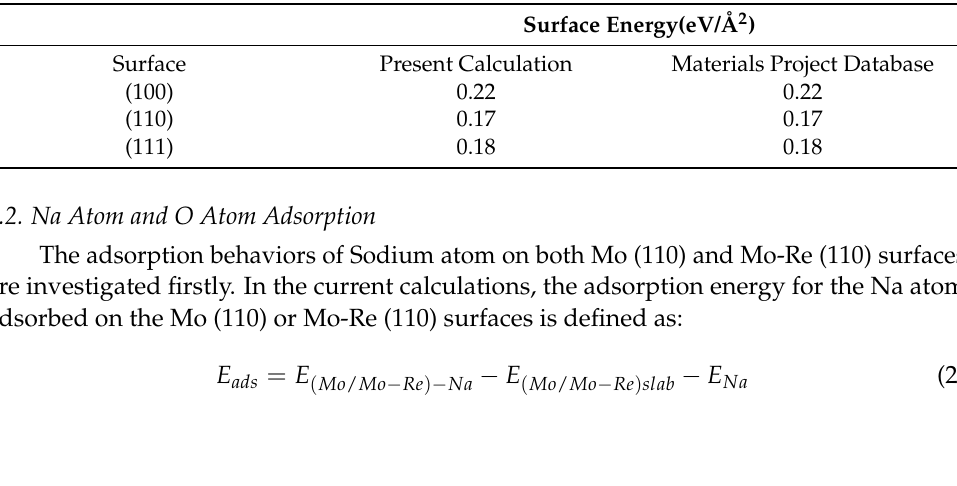
Table 1. Surface energies of low-index